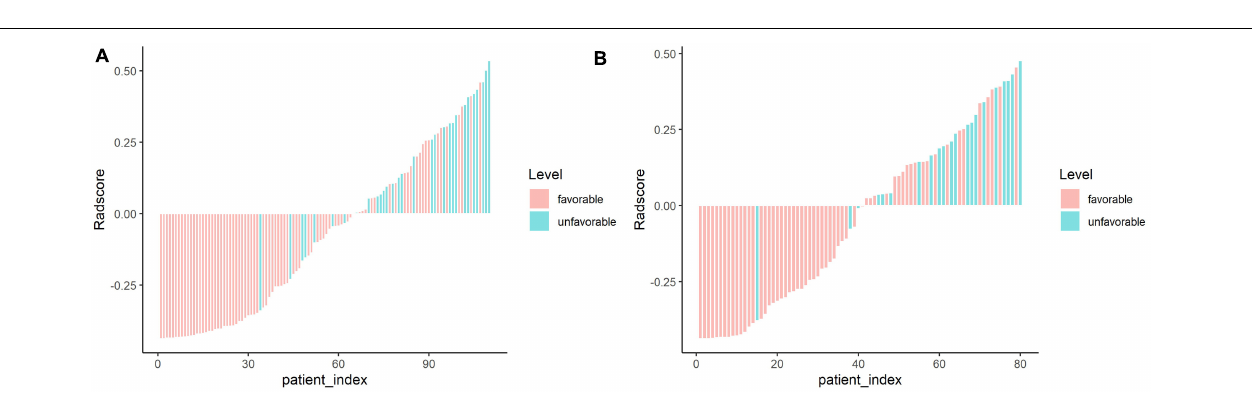
FIGURE 3 | The box diagrams of radscore for discriminating favorable and unfavorable outcomes with combined model in the training and validation sets. (A) Training set. (B) Validation set.